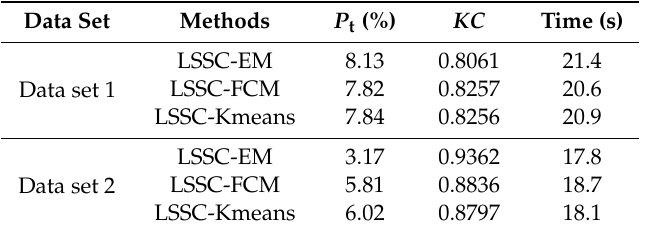
Table 5. The quantitative analysis of experimental results generated by